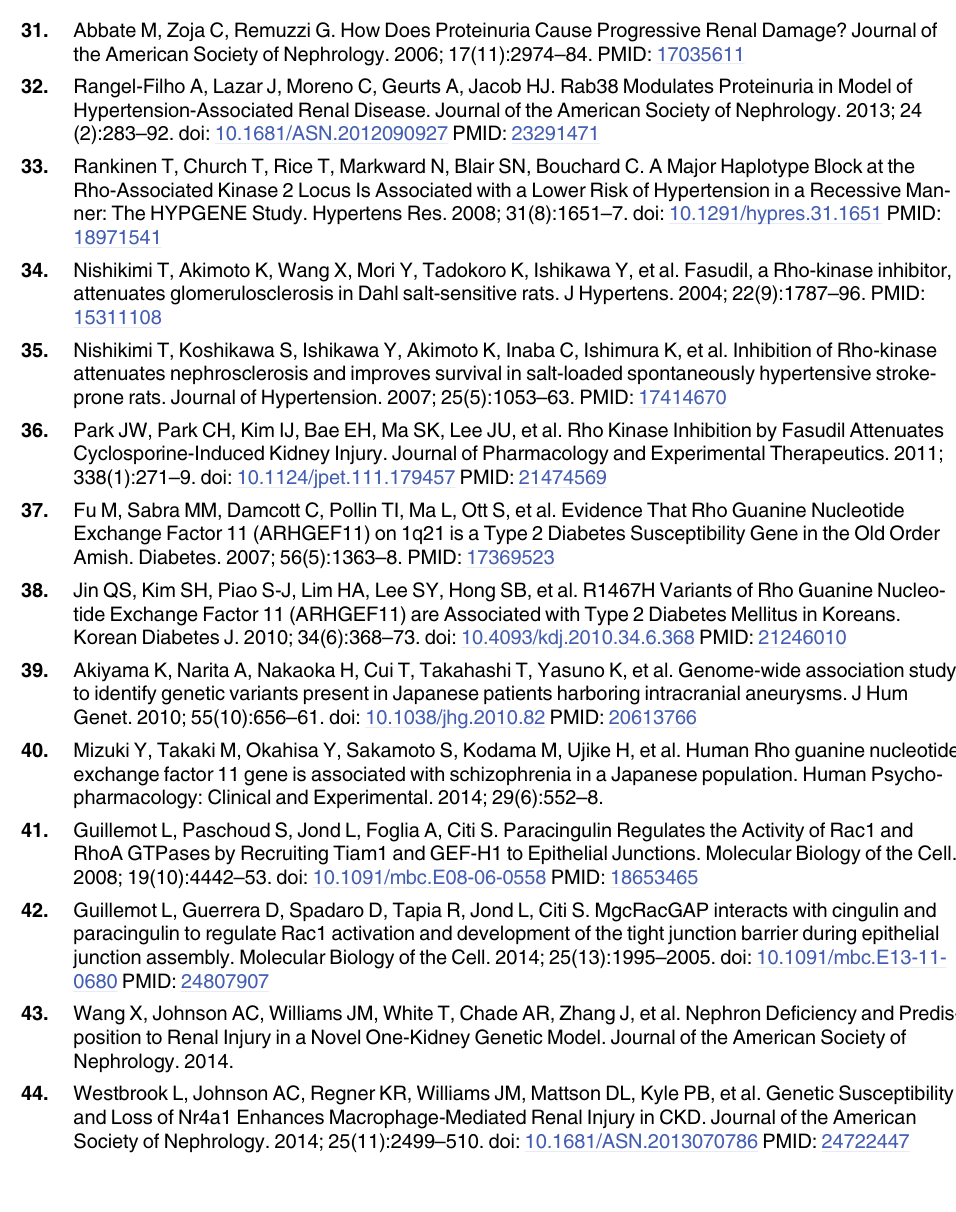
PLOS ONE | DOI:10.1371/journal.pone.0132553 July 14,